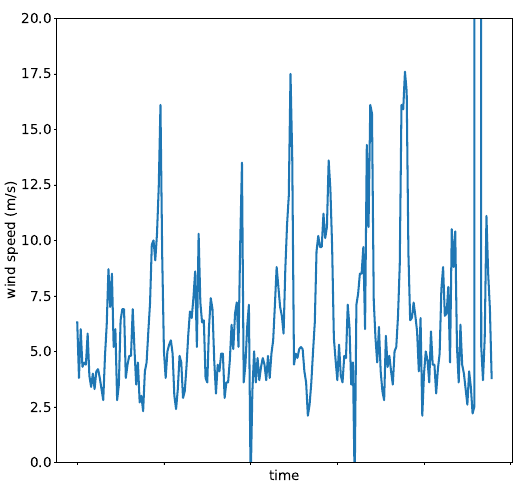
Figure 1. Segment of the Malpais Time